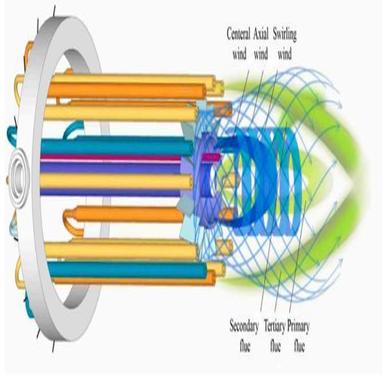
Flow image of swirling jet. Fig. 6. Built-in flame image monitoring device.